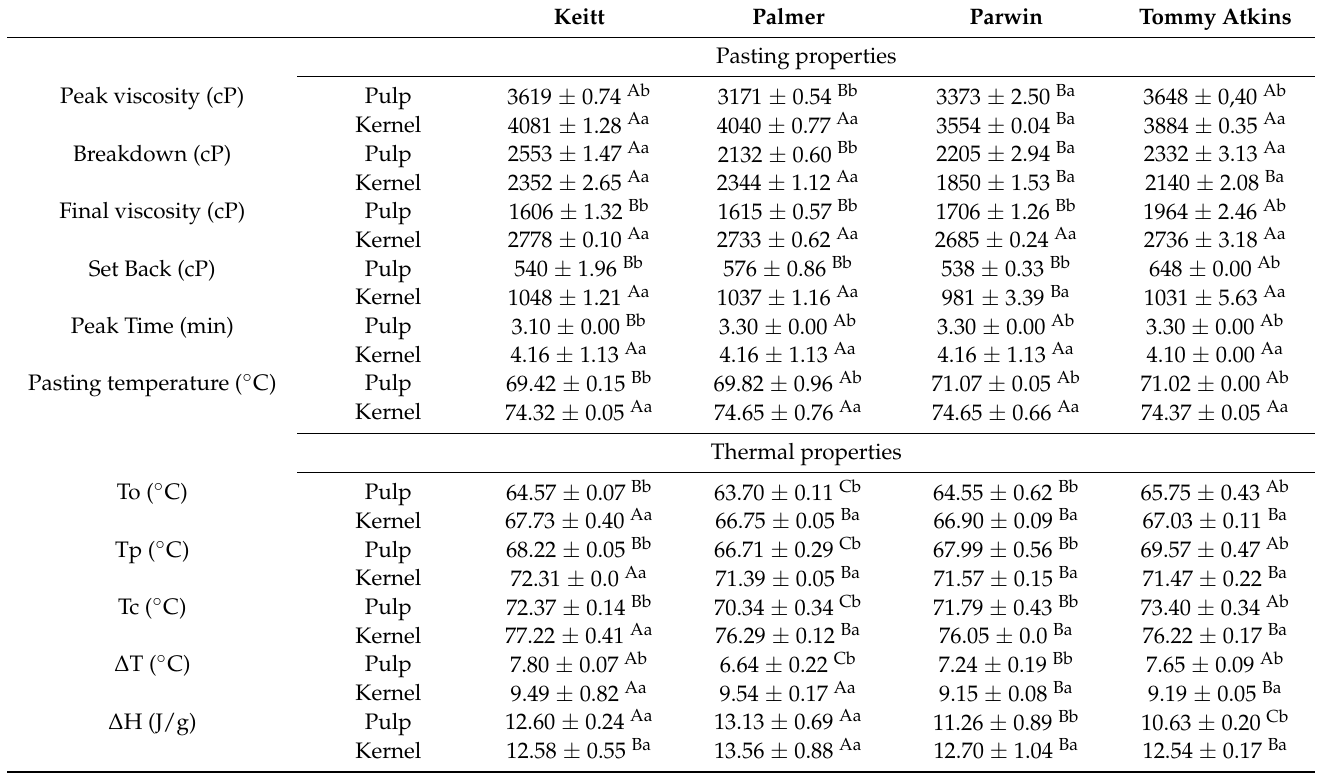
Figure 4. Pasting properties of isolated starches granules from mango fruits. Table 4. Pasting and thermal properties of mango